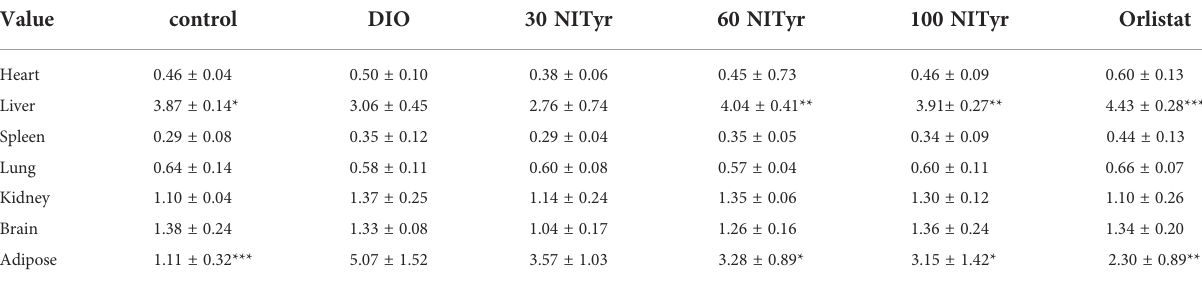
TABLE 2 Effect of NITyr on organ coef fi cient in mice.